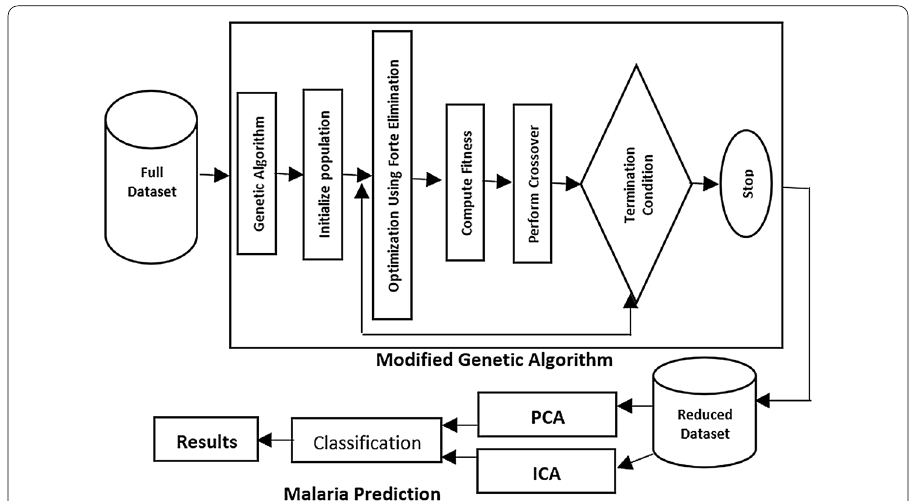
Fig. 1 proposed framework for RNA-Seq gene